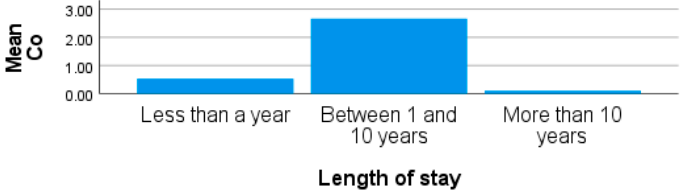
Figure 3. Showing blood Mn for length of stay in obese females living around site 3. The blood As concentrations from participants residing in site 3 were the highest, with minimum and maximum values of 0.70 µg/L and 3.43 µg/L, respectively, and a mean of 1.37 ± 0.67 µg/L. From site 1, the mean concentrations of As in the blood were 0.84 ± 0.41 µg/L and ranged from 0.27 µg/L to 2.20 µg/L (Table 1). From the results, it was observed that participants from sites 1 and 2 recorded lower mean concentrations.